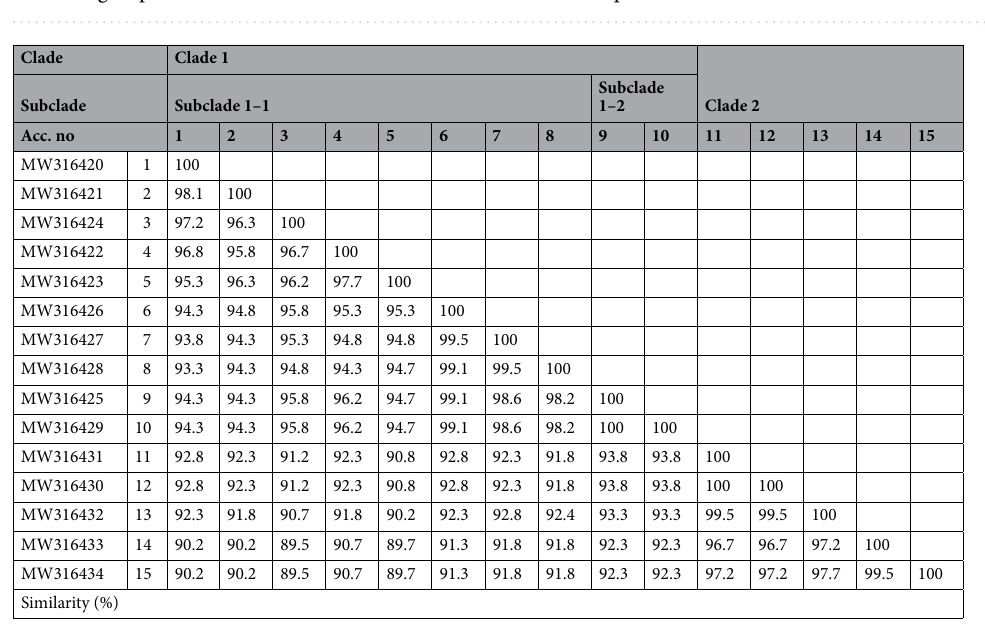
Table 3. Similarity of the L. sabrazesi cytb gene sequences as detected in chicken sampled in Thailand.